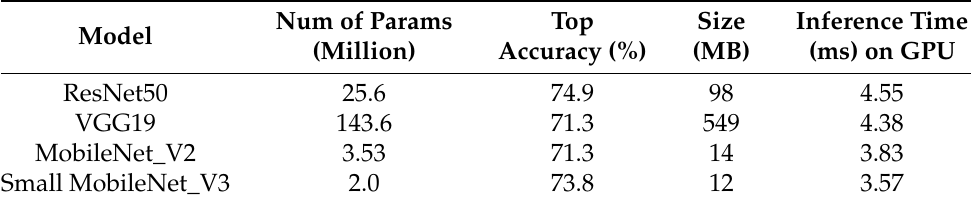
Table 2. Sample of the available models.